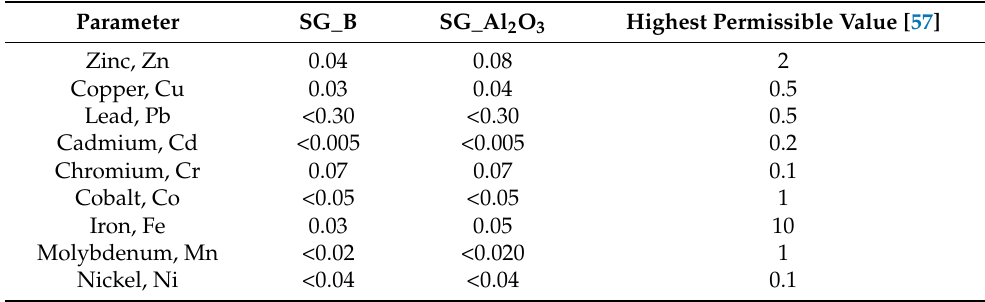
BLQs *—below the limit of quantification. Table 8. Leachability of heavy metals (mg/L) from geopolymer rock wool binders in a commi- nated form.